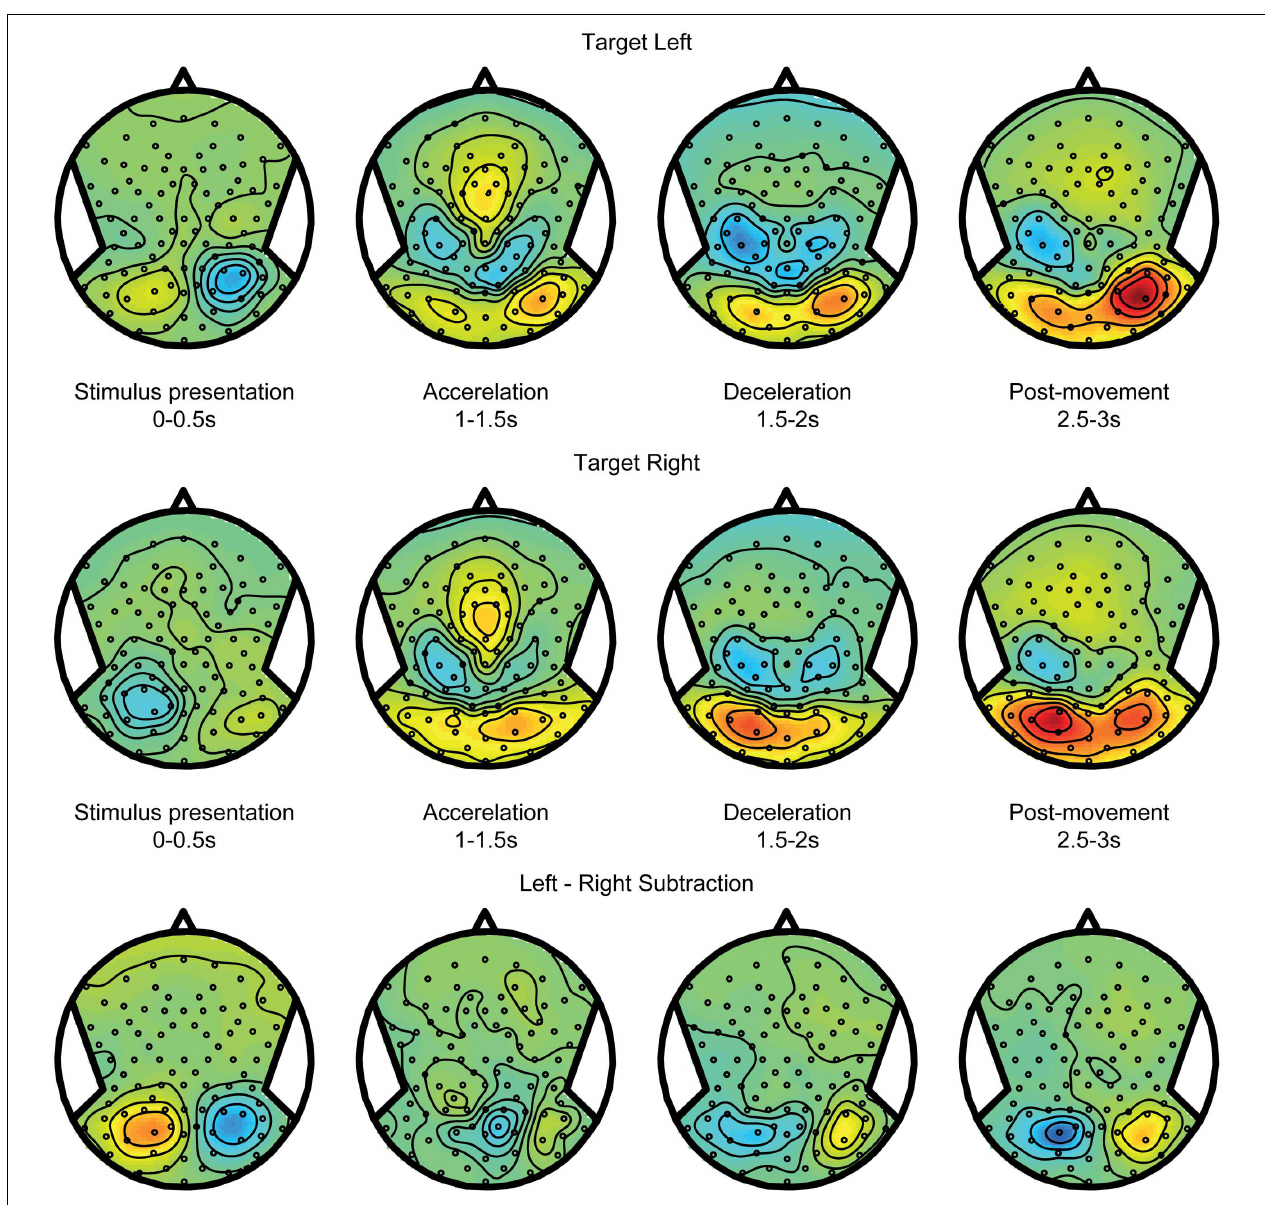
FIGURE 4 | Target coding activity. EEG alpha-band scalp topoplots of the body-fixed condition, separately averaged for targets on the left (Top) and right (Middle) , before, during and after motion. Activity is averaged over left and right motion directions. (Bottom) Subtraction of left and right target conditions (above). This contrast isolates effects of left vs. right